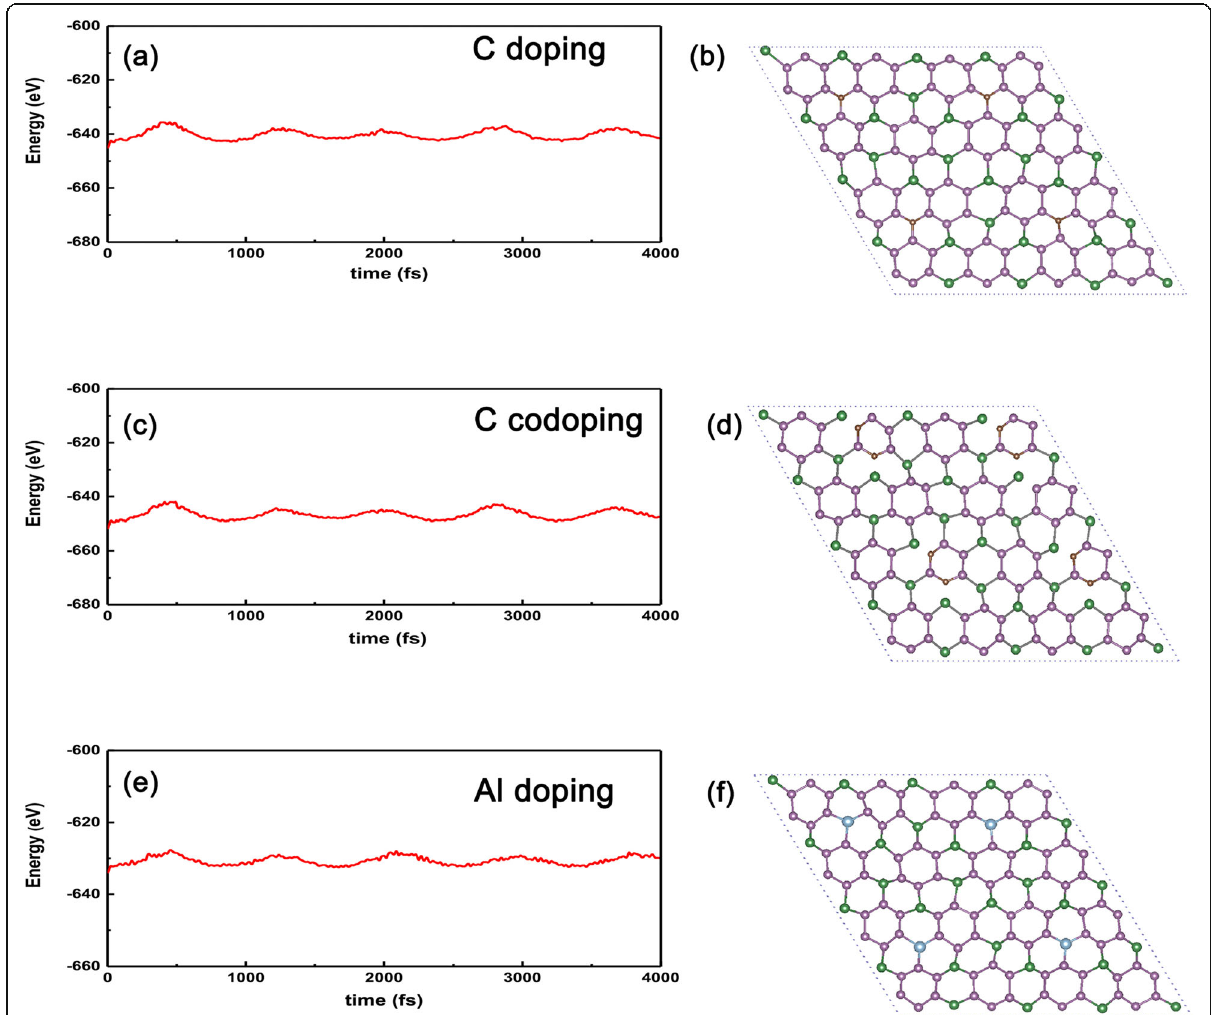
Fig. 9 AIMD for the C, two C, and Al atom-doped systems. AIMD confirms the thermal stability of a C atom-doped GeP 3 with substituting Ge atom, c two C atoms doped GeP 3 with substituting two P atoms, and e Al atom-doped GeP 3 with substituting at 300 K. The structures in b C, d two C atom, and f Al correspond to their final structures after 4000